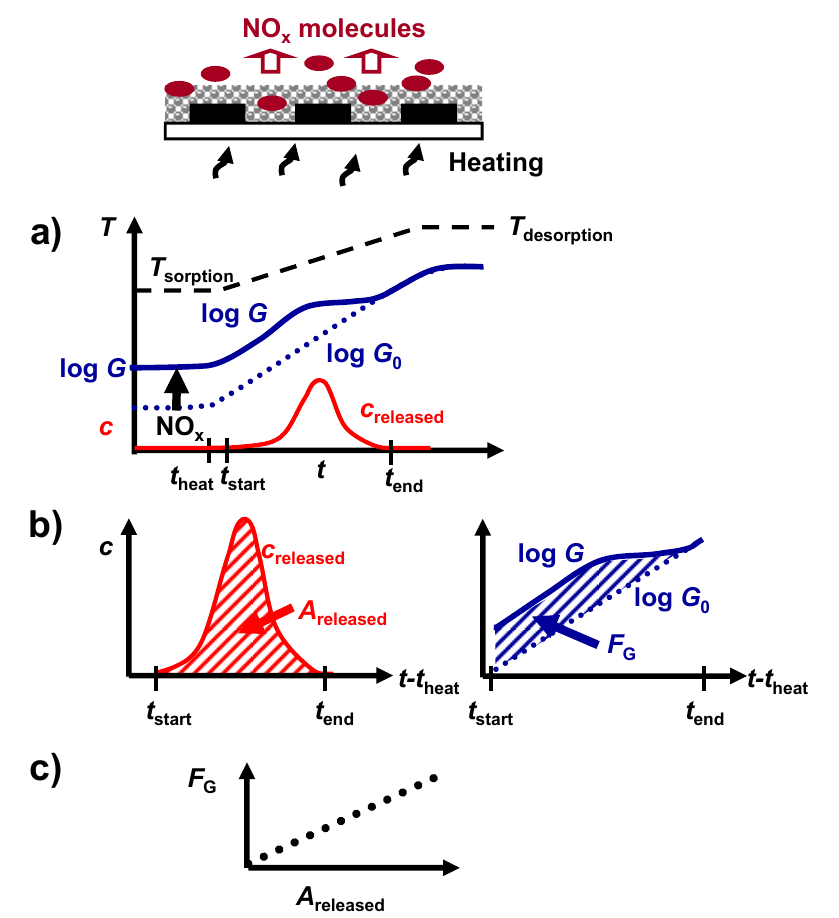
Figure 8. Data analysis for eTPD: ( a ) time dependence of conductance log G and outlet NO concentration c , ( b ) determination of released amount A x released , ( c ) F as a function of A response F G G released